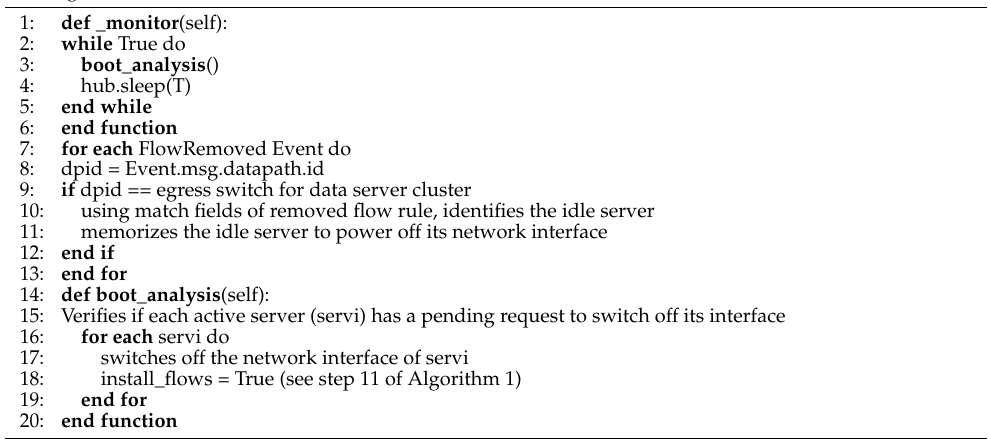
Algorithm 2 The controller can process any flow rule deleted message sent from any switch. Using the match fields of the deleted flow rules, the controller can identify the servers to switch off their network interface, saving server resources.